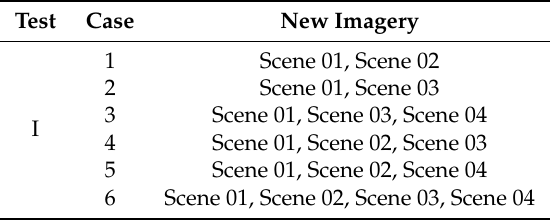
Table 3. SPOT-5 images for georeferencing with the conventional